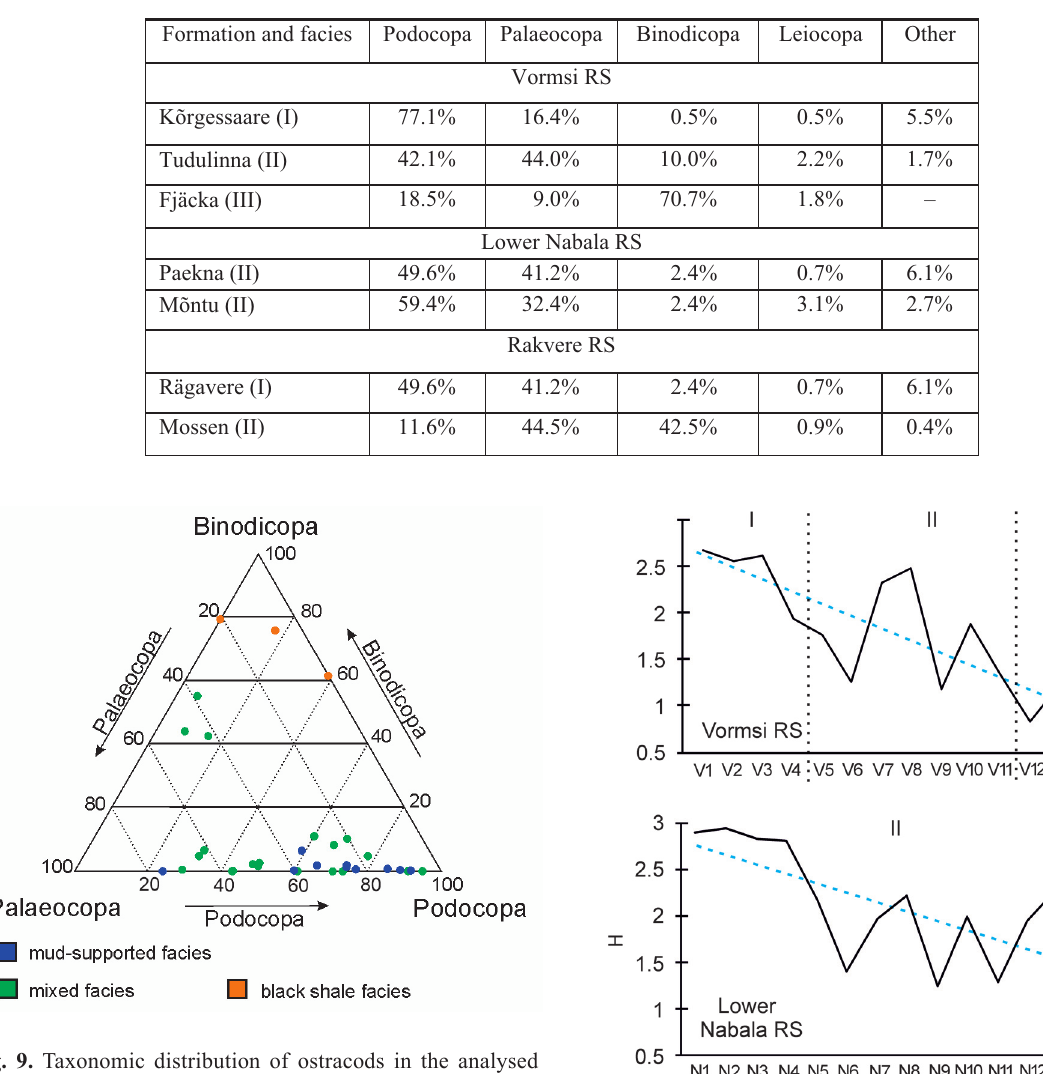
Fig. 9. Taxonomic distribution of ostracods in the analysed section intervals.